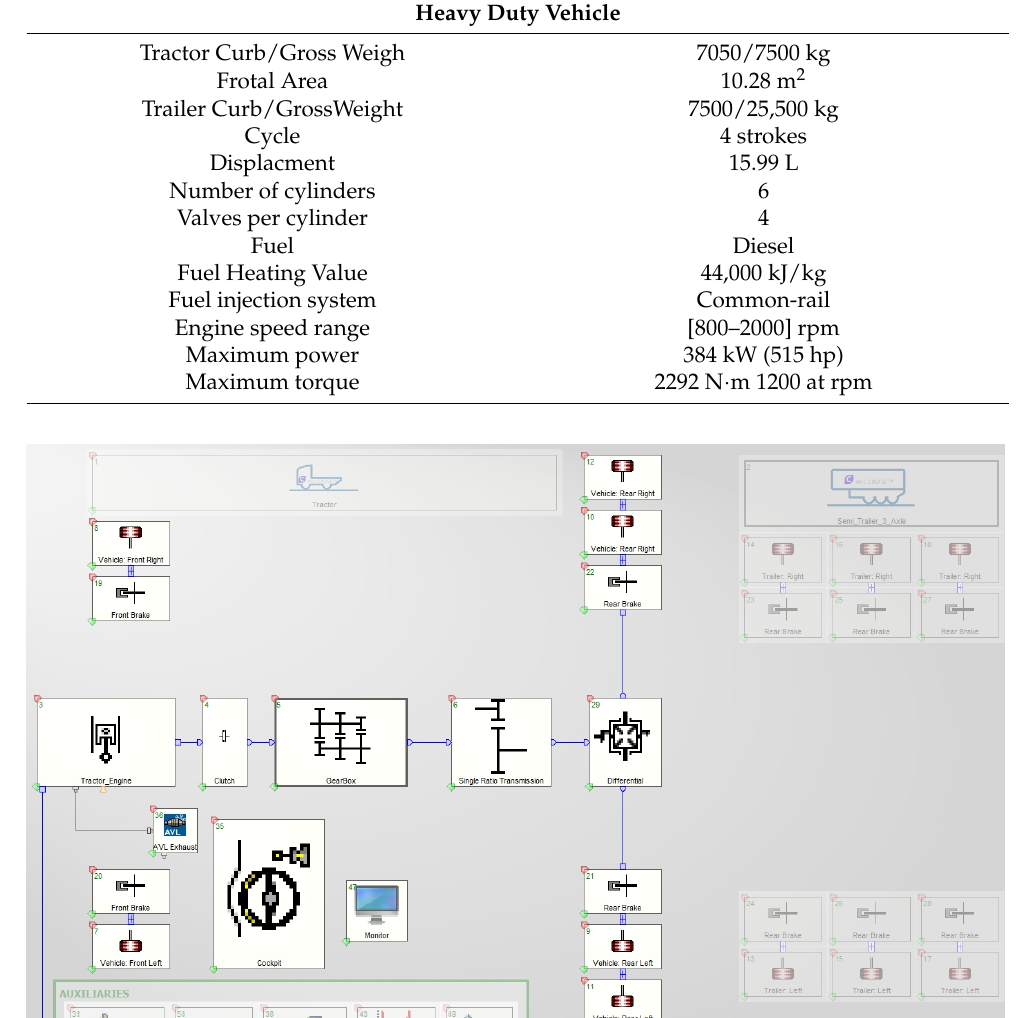
Table 2. Main design features of the test vehicle—adapted from [30].